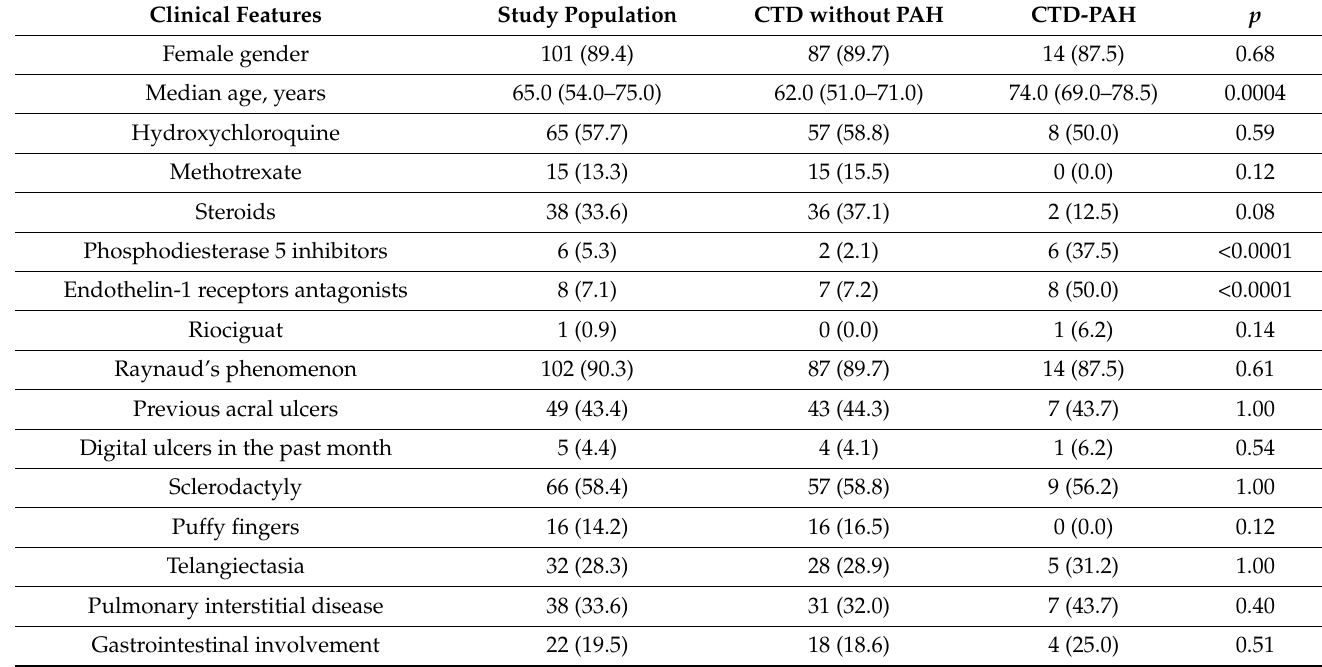
Table 1. Clinical and laboratory features of the study population. Abbreviations: CTD—connective tissue diseases; PAH—pulmonary arterial